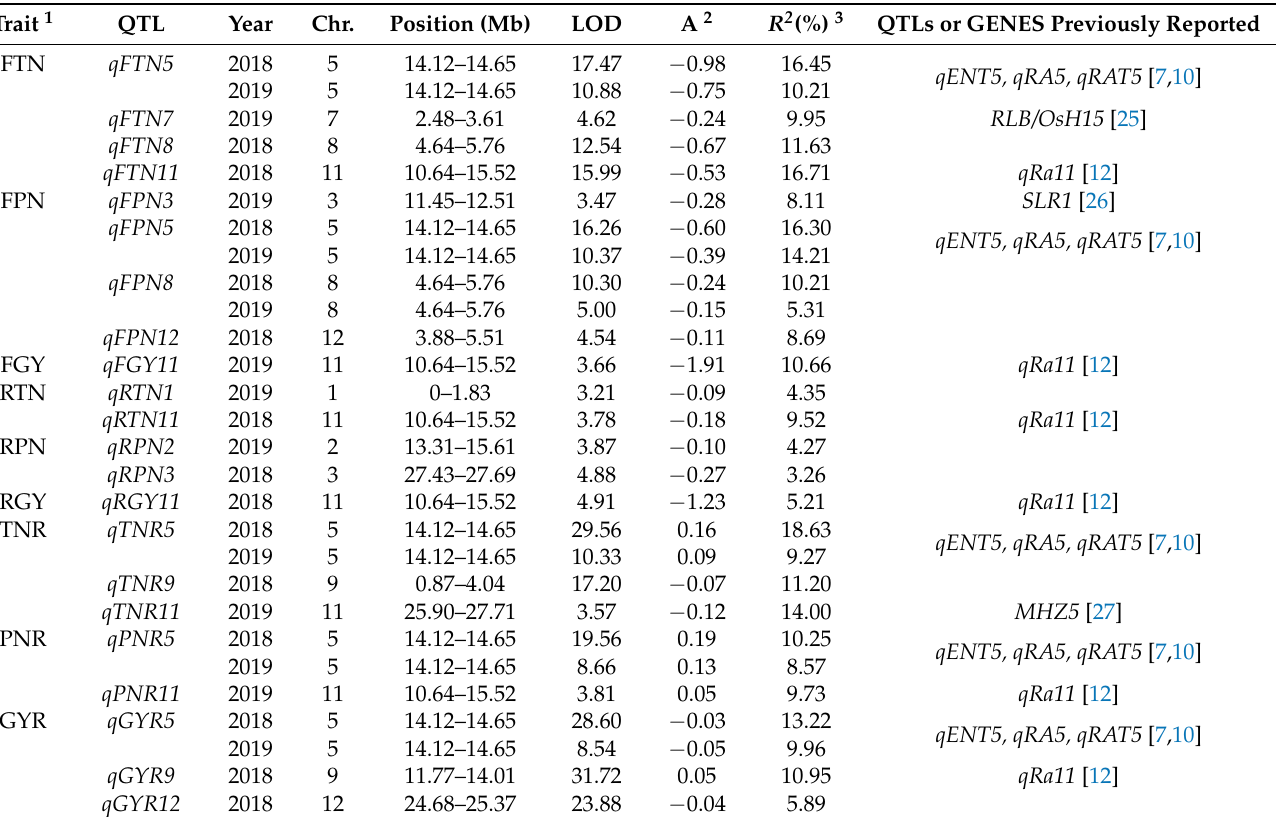
Table 3. Main-effect QTLs for ratooning-ability-related traits in the IL population derived from MH63 and